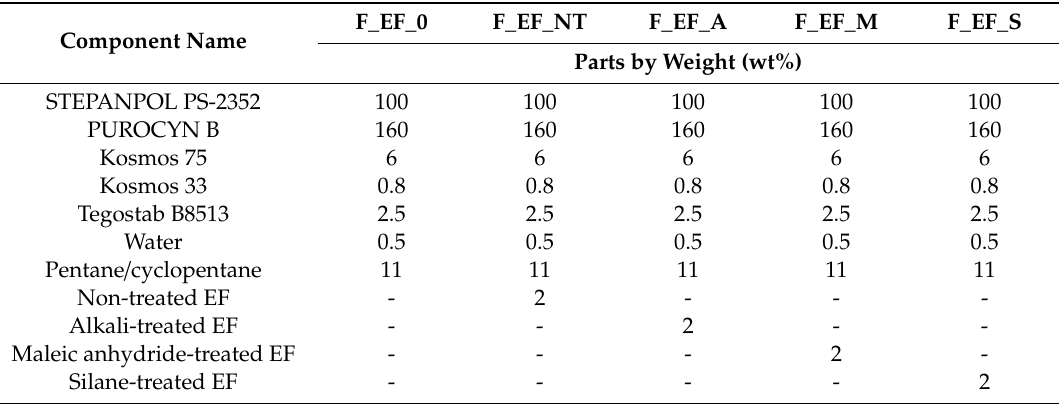
Table 1. Polyurethane foams